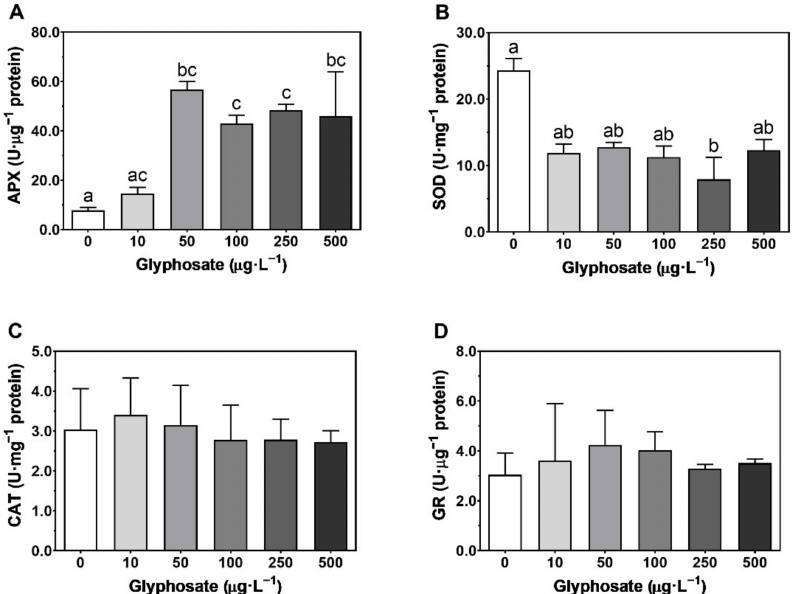
Figure 6. Ascorbate peroxidase (APX, ( A )), superoxide dismutase (SOD, ( B )), catalase (CAT, ( C )), and glutathione reductase (GR, ( D )) enzymatic activities in Ulva lactuca following a 48-h exposure to a glyphosate-based herbicide formulation in different concentrations (mean ± s.d., n = 3, different letters indicate significant differences at p < 0.05).